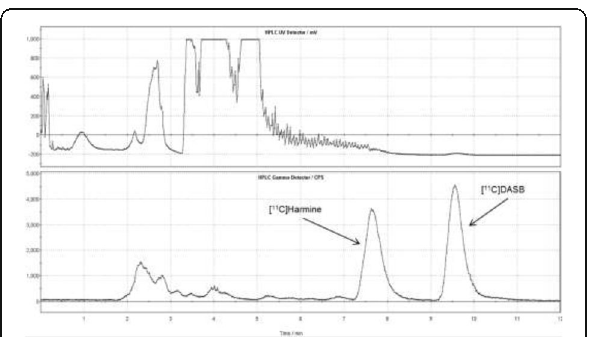
Fig. 2 (abstract OP06). Exemplary RP-HPLC chromatogram for the separation of [ 11 C]Harmine and [ 11 C]DASB in a single